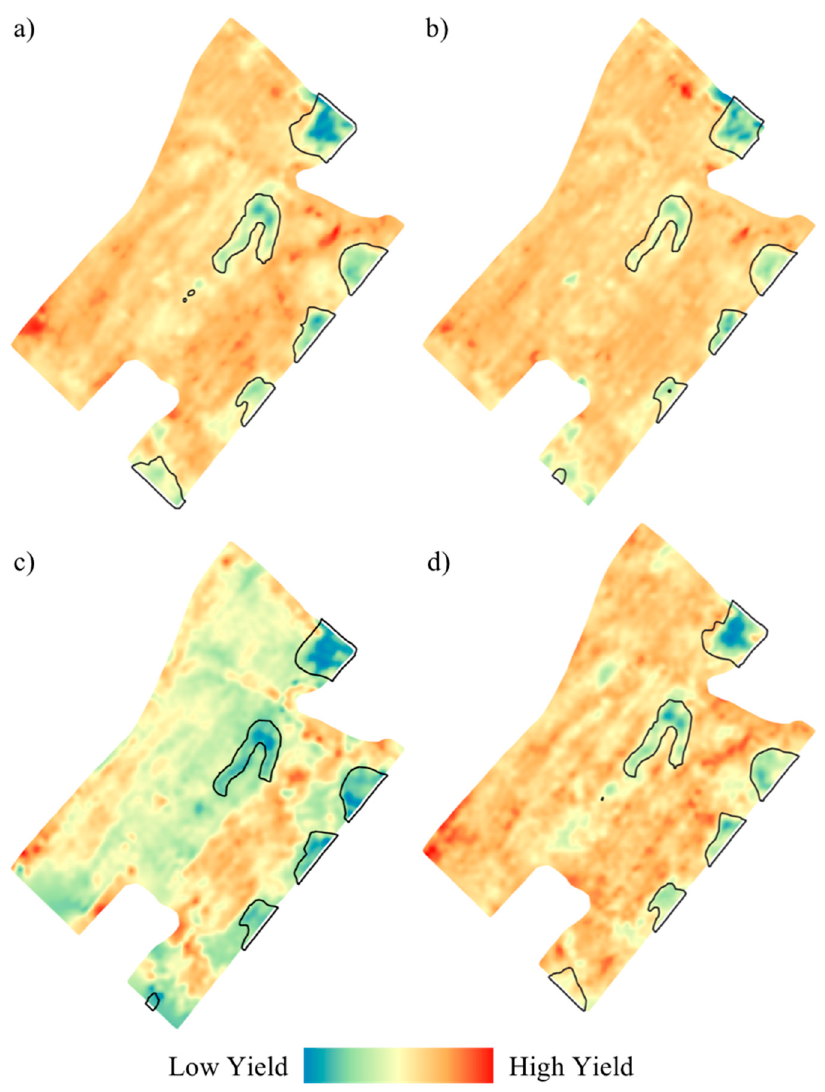
Figure 6. Normalized observed crop yield data for ( a ) study period average; ( b ) corn; ( c ) winter wheat; ( d ) soybeans. Black outline polygons indicate GWR predicted lowest 10 percent of crop yield.